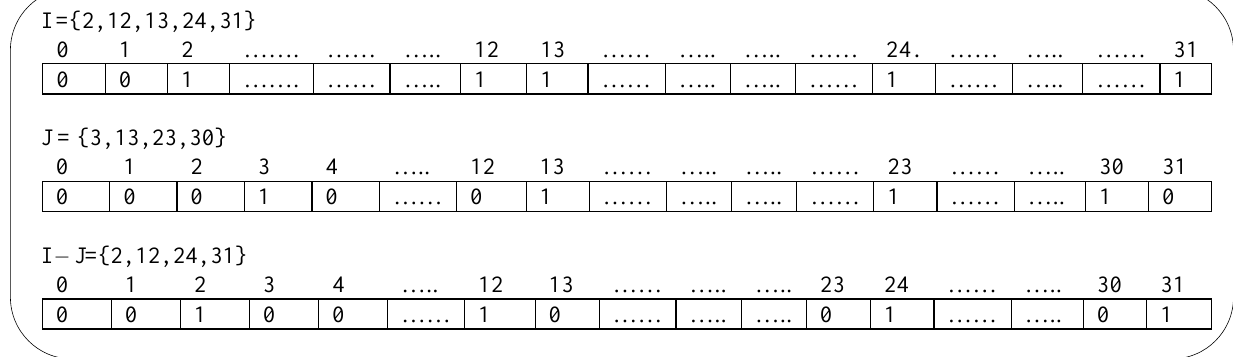
Figure 4. Set difference operation of the itemsets I = {2, 12, 13, 24, 31} and J = {3, 12, 13, 23, 30}.